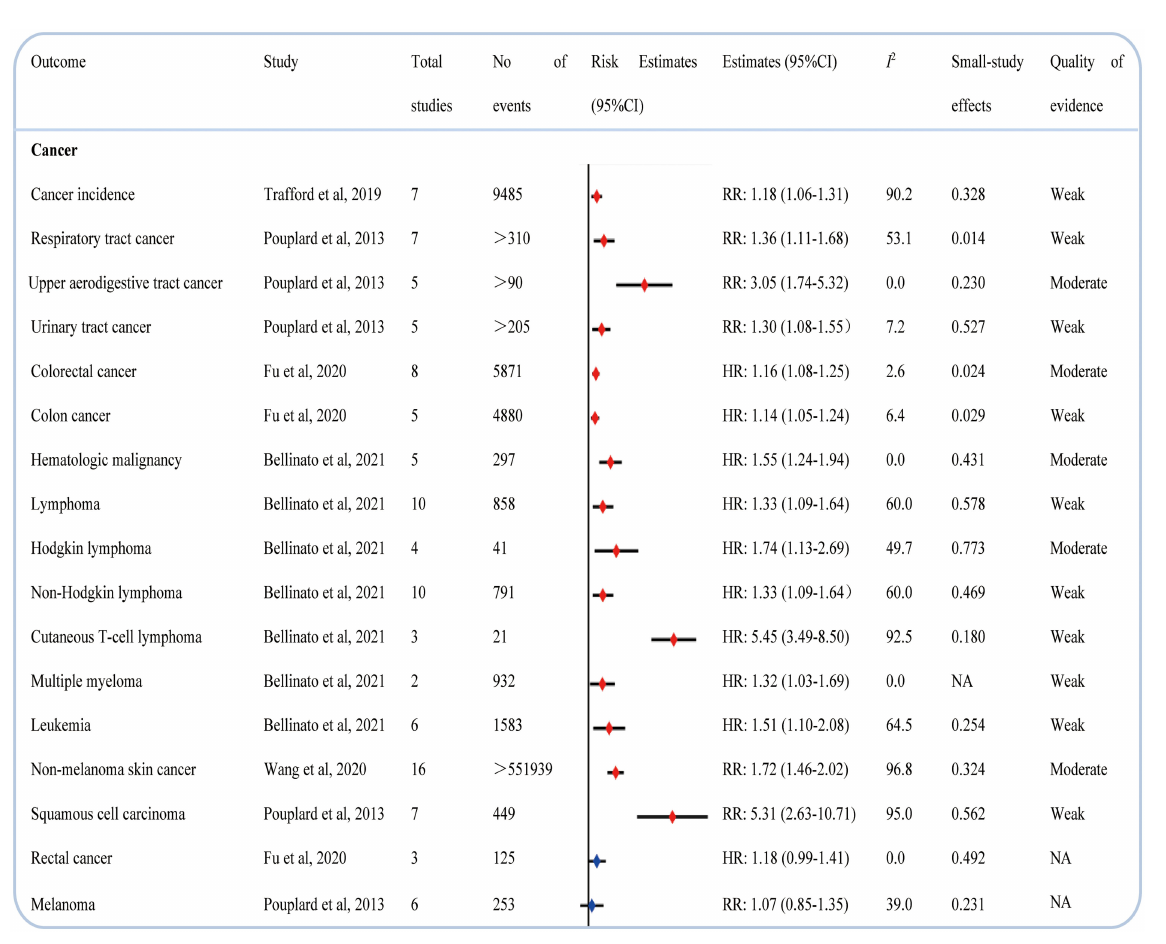
hemorrhage, low birth weight, and small for gestational